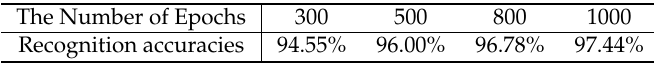
Table 7. Recognition accuracies vs. Number of epochs.